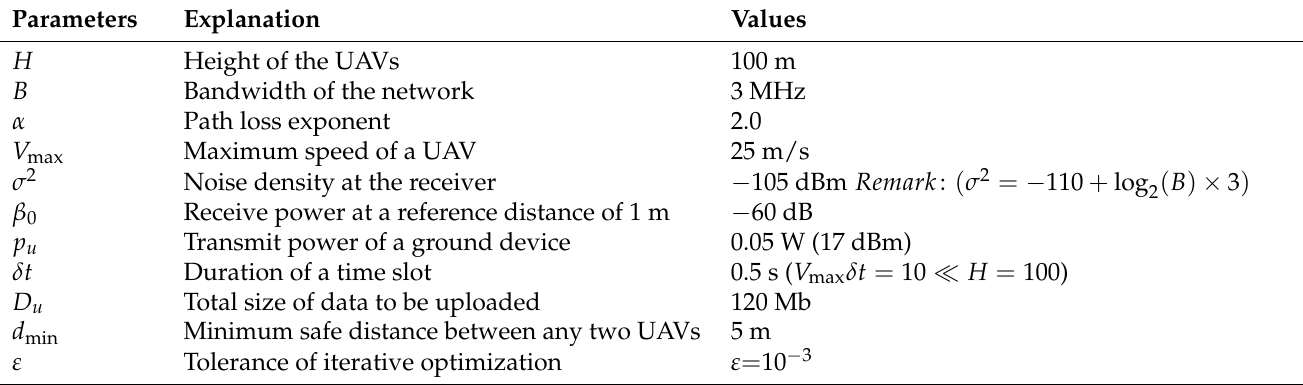
Table 2. Simulation parameters for the multi-UAV-enabled data collection